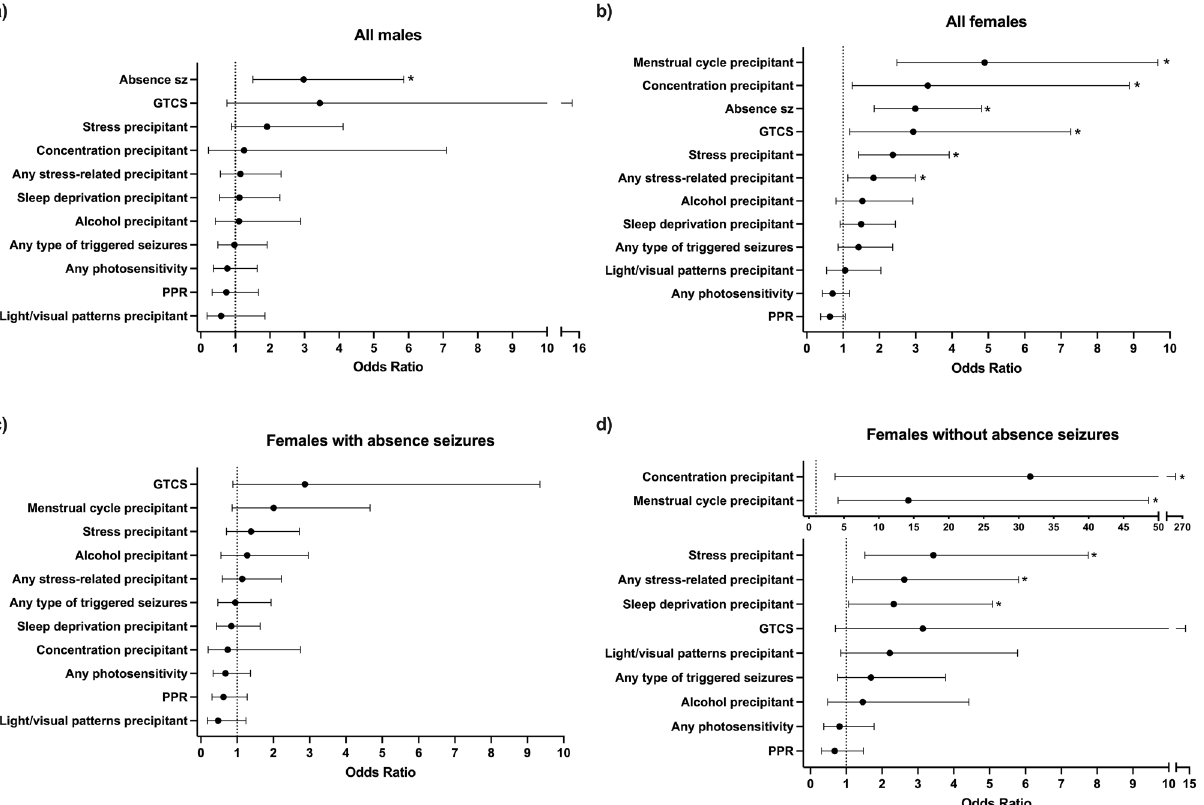
Figure 1. Predictors of drug resistance in subgroups of JME. Odds of being drug-resistant in males ( a ) and females ( b ) with seizure precipitant predictors (* = p < 0.05 in univariate analysis). Odds of drug resistance in females was further stratified by a history of absence seizures due to its association with triggered seizures in females ( c , d ). Note the two scales of x-axis (top and bottom) in ( d